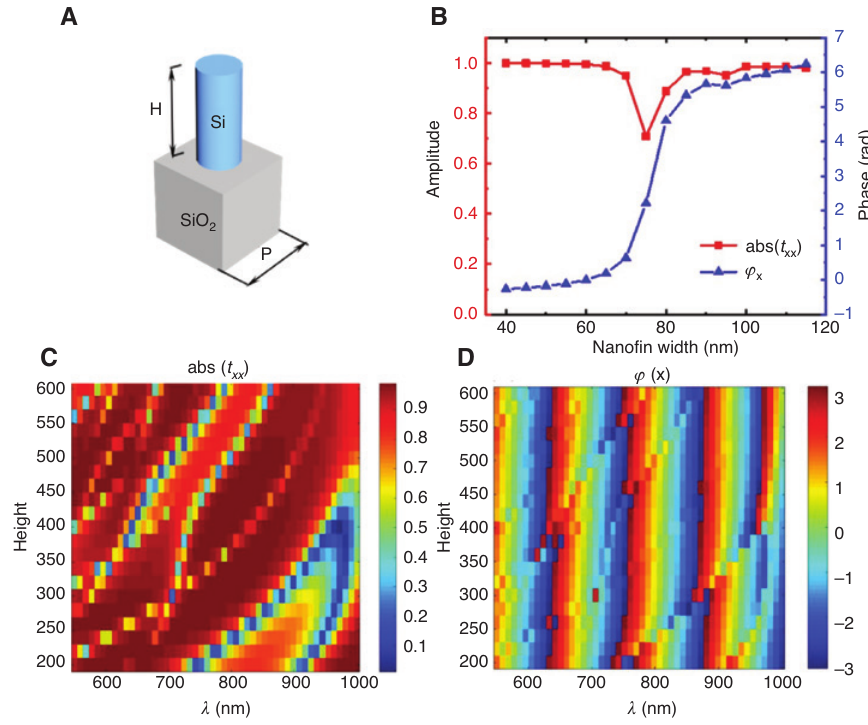
Figure 3: Simulation of the HMS. (A) The unit cell composed of cylinder nanopost above the silica substrate. (B) Parameter sweep of amplitude and phase by varying the radius of nanopost. (C, D) 2D sweep by varying the incident wavelength and height of